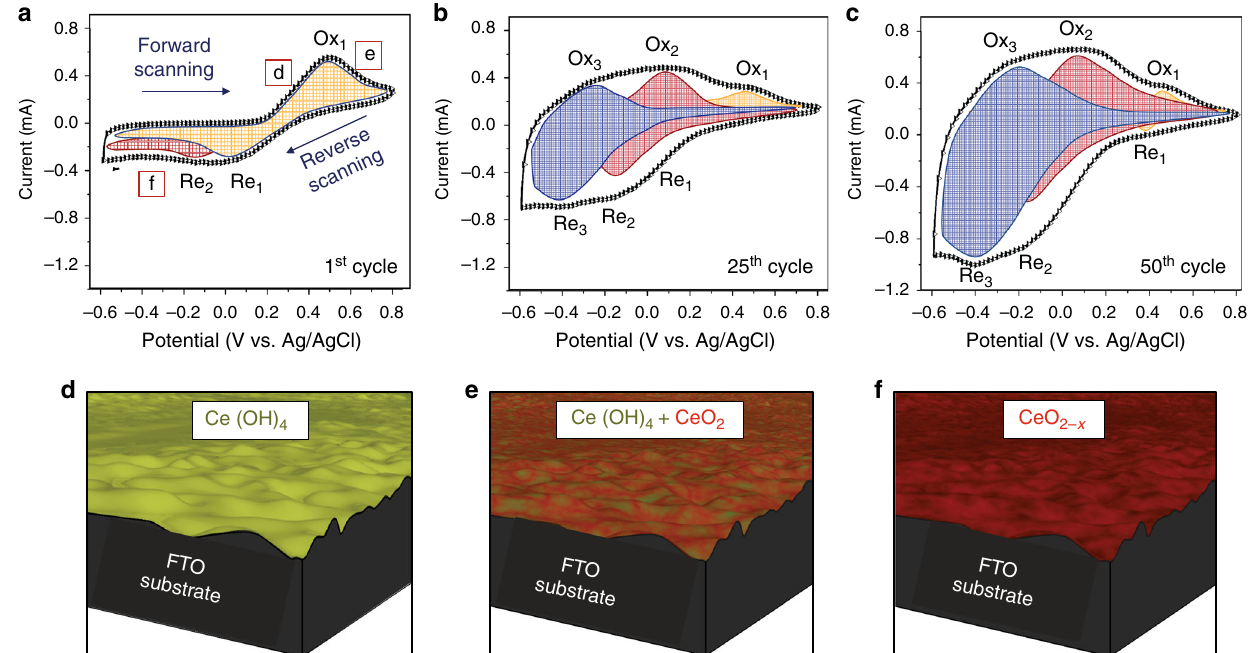
Fig. 2 Mechanism of CeO 2 − x thin- fi lm deposition. Voltammograms obtained at a scan rate of 300 mV s − 1 : a 1st cycle. b 25th cycle. c 50th cycle. d Schematic of Ce(OH) 4 nanostructure deposited during forward scanning. e Schematic of mixed Ce(OH) 4 + CeO 2 nanostructure during chemical